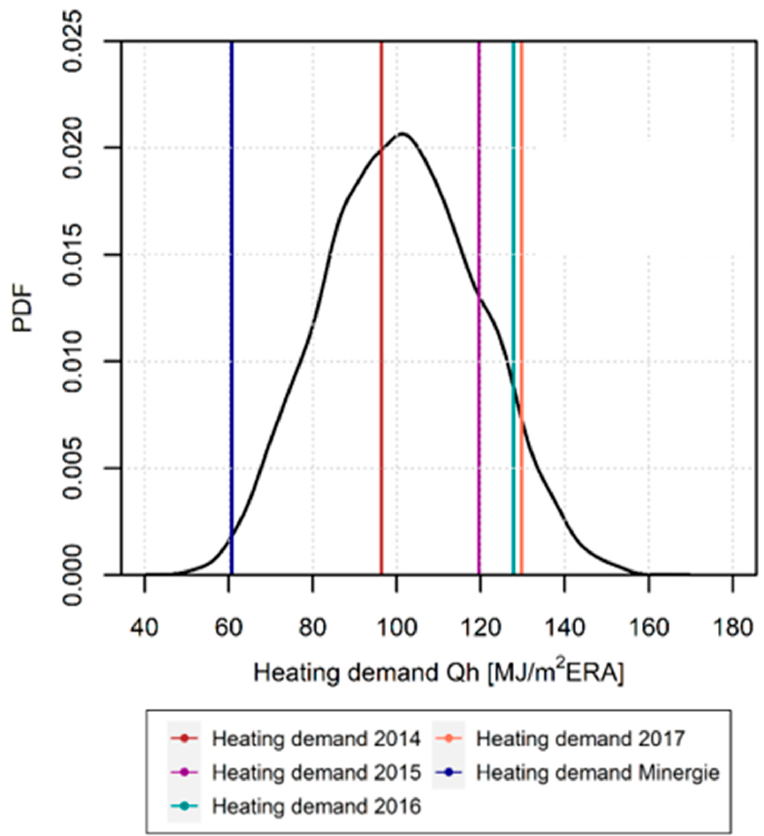
Figure 4. Probability density function of the heating demand, deterministic heating demand (SIA 380/1 and Minergie ® ) and measured data period [2014–2017].